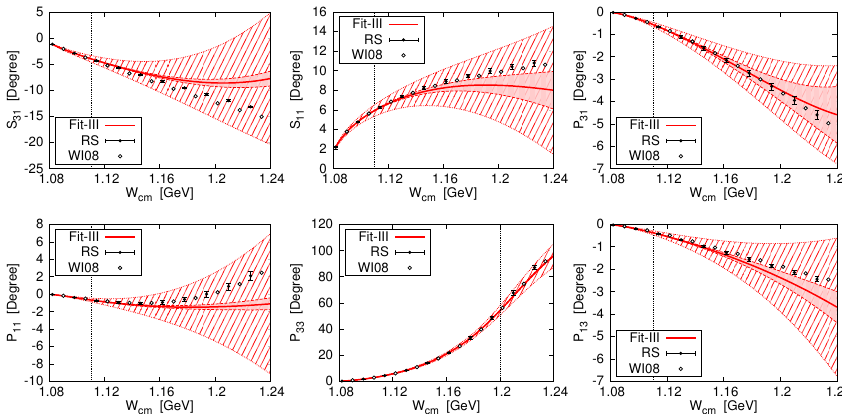
Figure 1. Phase shifts corresponding to Fit-III. Dots with error bars represent the RS phase shifts; Cir- cles - GWU phase shifts. The red line is the result of Fit III. The red narrow error bands are uncertainties propagated from the errors of LECs. The wide dashed error bands are theoretical